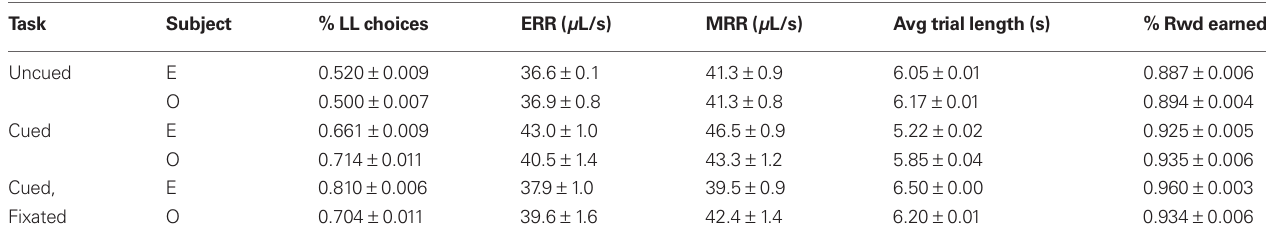
Figure 2 . Behavior, pooled across all days, was fit to standard hyper- bolic discounting models using a maximum likelihood procedure